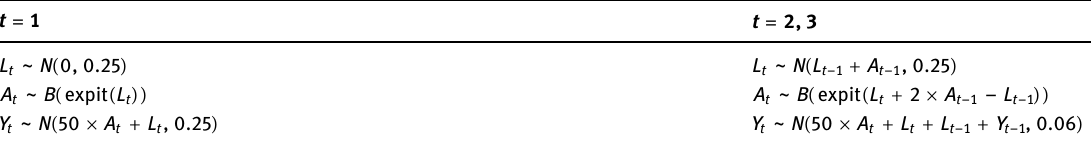
Table 4: DGP for simulation 1